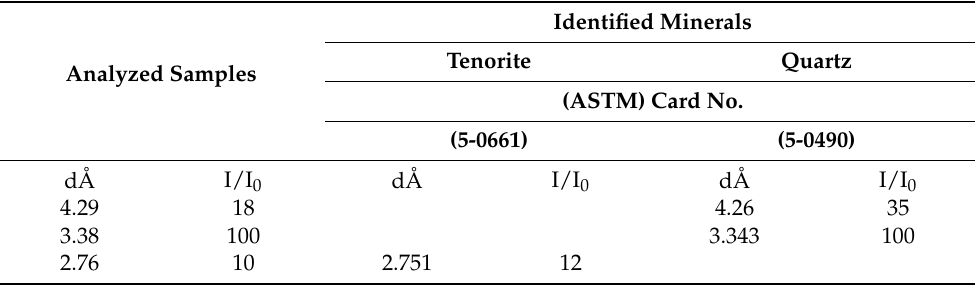
Table 3. Identification of tenorite and associated quartz from monzogranite using X-ray diffraction (XRD) technique at Monqul, north Eastern Desert,